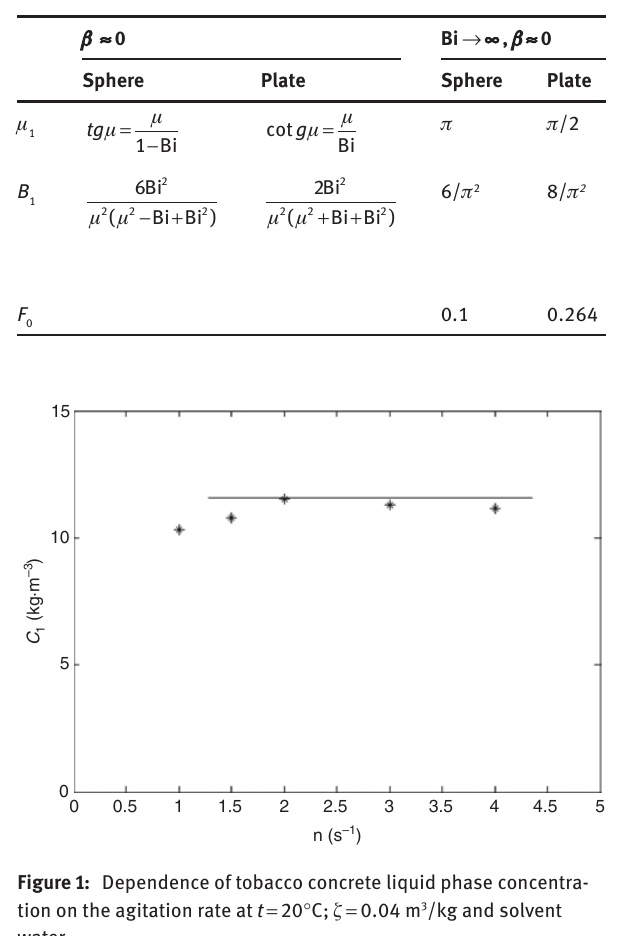
Table 1: Boundary values of the parameters for a plate and sphere.